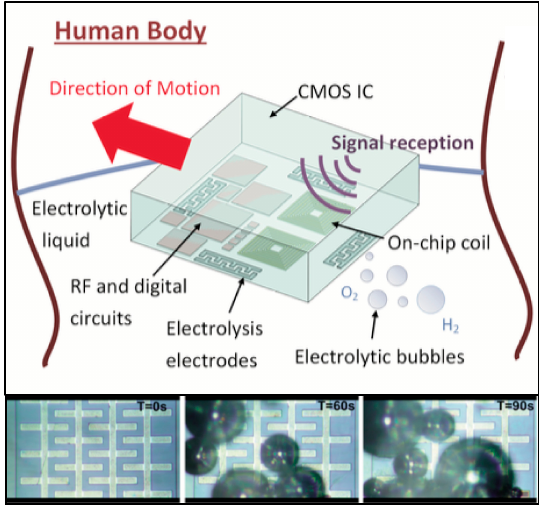
Figure 1. Representation of the remote-controlled device and its movement mechanism ( top ); with photographs of electrolysis bubble formation over time ( bottom ). Reproduced with permission from [9].